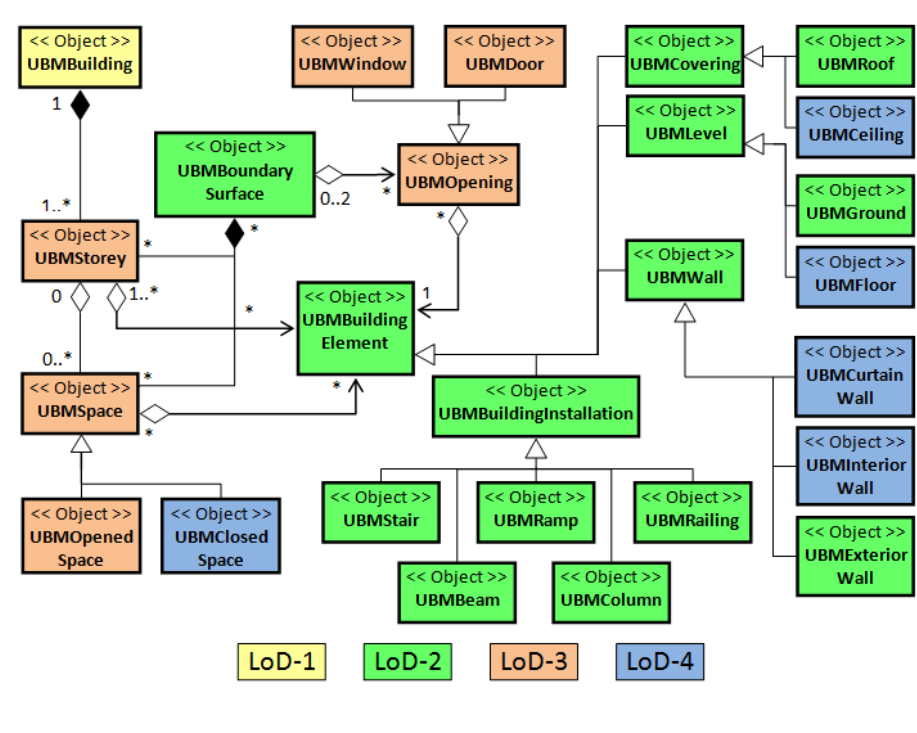
Figure 4. The unified building